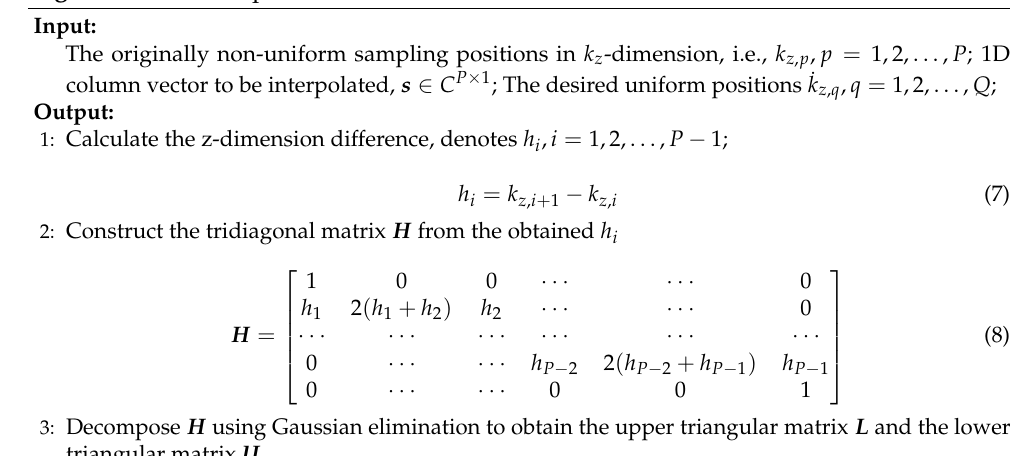
Algorithm 2 Cubic spline